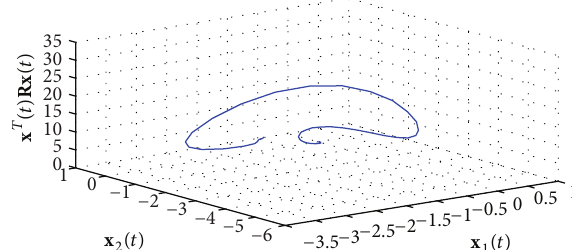
Figure 4: The graph of x 𝑇 (𝑡) Rx (𝑡) (𝑡 ∈ [0, 𝑇]) of closed-loop controlled